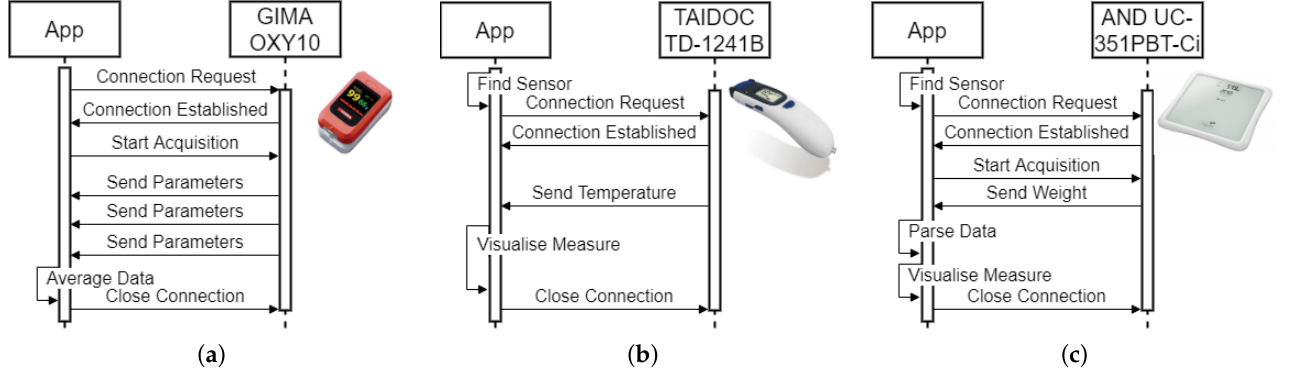
Figure 2. Sequence diagram of acquisitions from the different sensors: ( a ) acquisition of SpO 2 and HR from sensor GIMA OXY10; ( b ) acquisition of body temperature from sensor TAIDOC TD-1241B; ( c ) acquisition of body weight from sensor AND